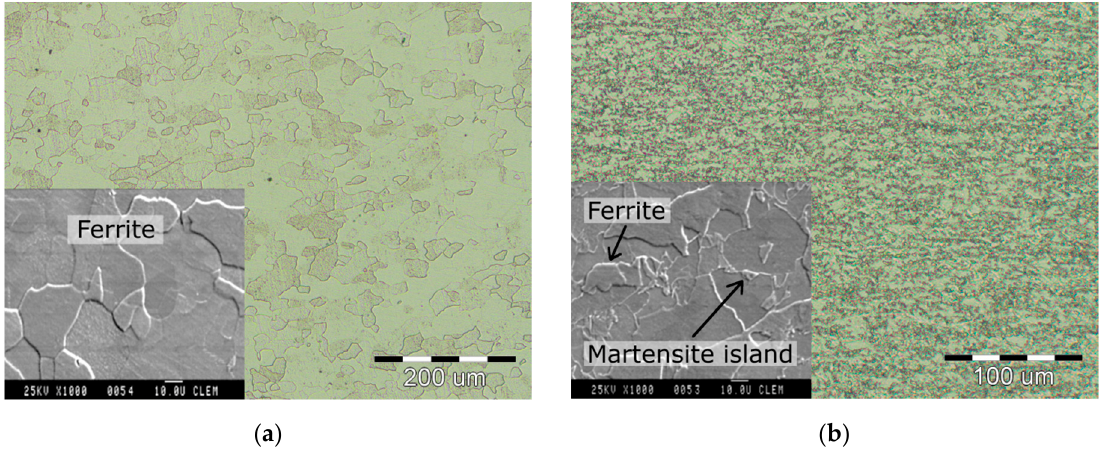
Figure 2. The microstructure of investigated steels: ( a ) Interstitial free (IF) DX 51D steel. ( b ) Dual phase (DP) 500 HCT 590X steel.